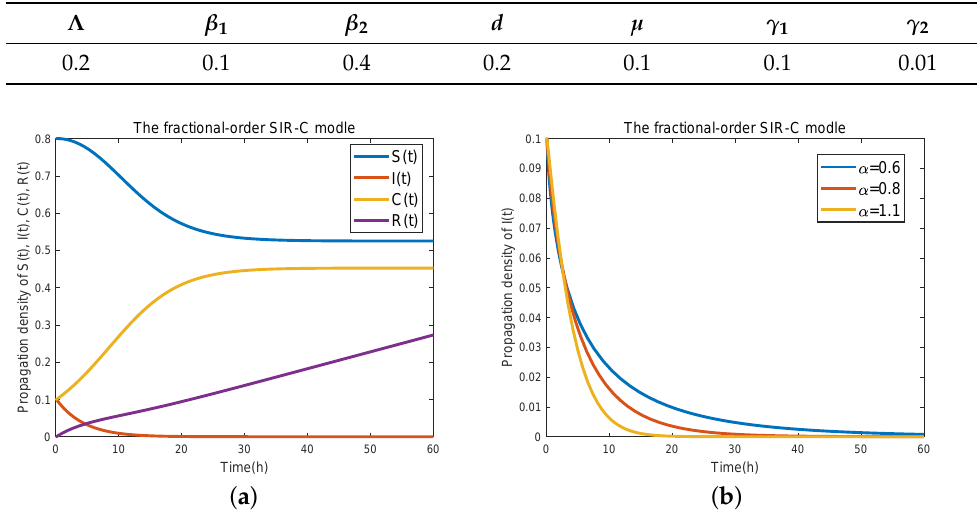
Table 3. Parameter for the global asymptotic stability of E 1 .